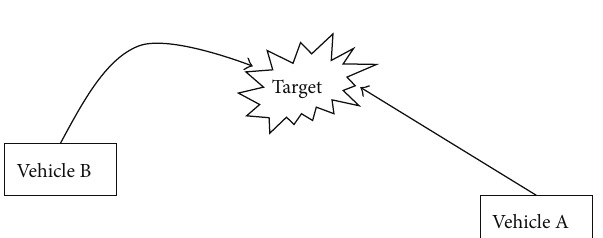
Figure 13: Time on Target illustrative diagram.